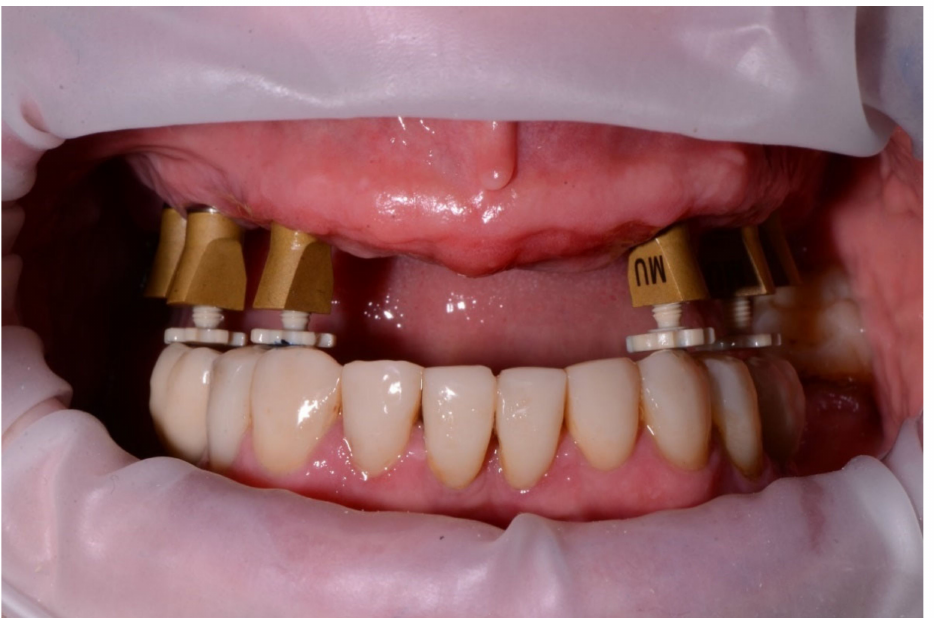
Figure 7. Bite pillars inserted into the screw holes of the scan parts of the dual-function scan bodies mounted on multi-unit abutment level, adjusted at the desired occlusal vertical dimension (OVD). The treatment time for the digital bite registration technique was recorded from the in- stallation of the dual-function scan bodies at a torque value of 10 Ncm, installing/adjusting the bite pillars and the registration of 2 lateral bite-scans. The treatment time ended when the digital casts were aligned in the intraoral scanner software and ready to be sent to the dental